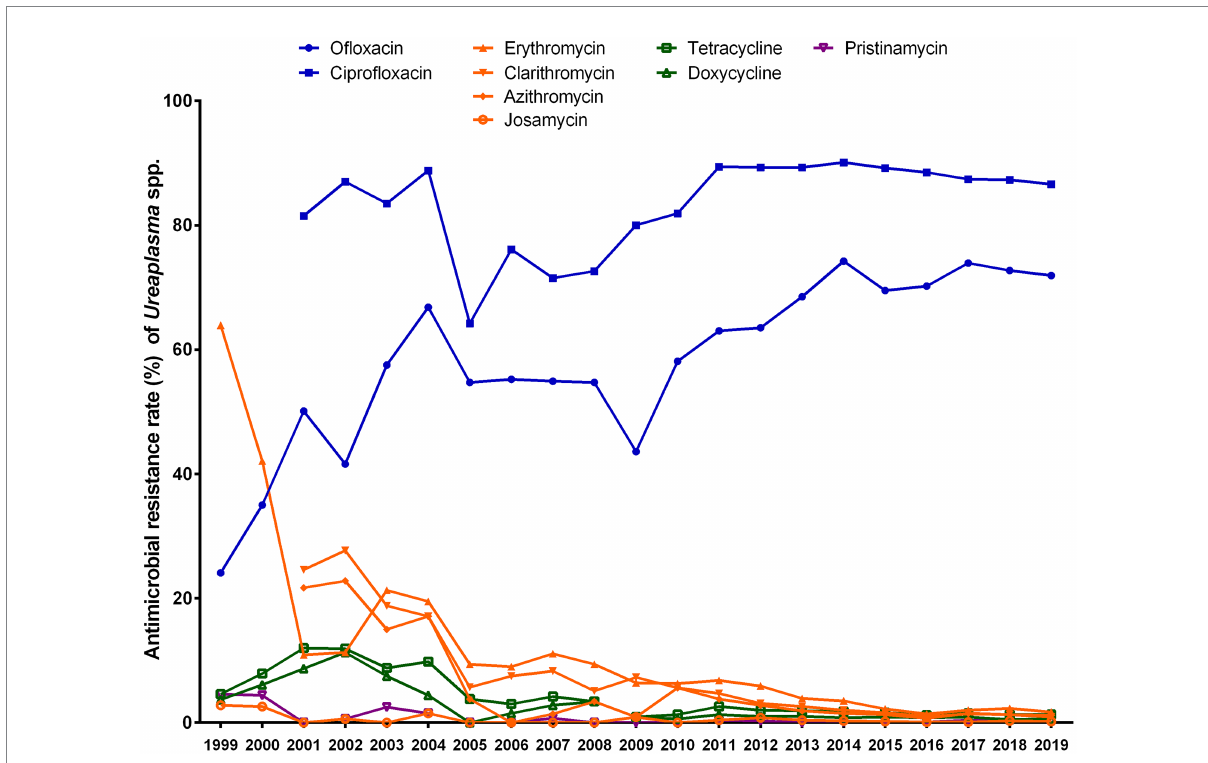
FIGURE 2 Trends in the antibiotic resistance rates of Ureaplasma spp. to nine antibiotics from 1999 to